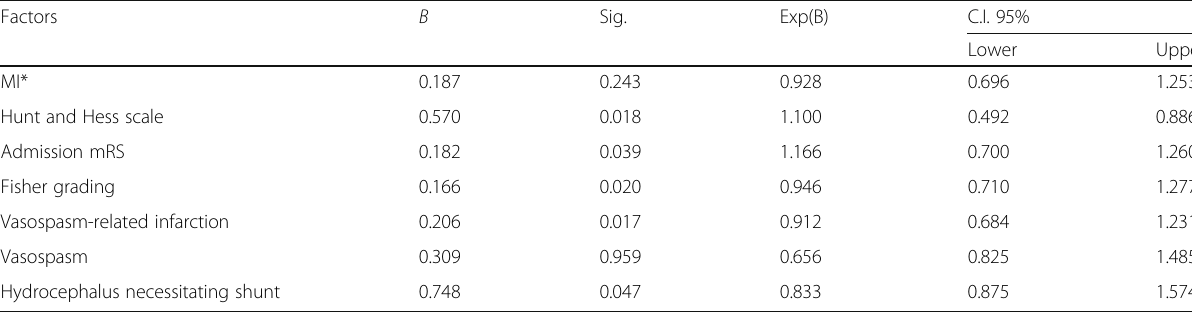
Table 6 Logistic regression analysis for variables which are possibly affecting the